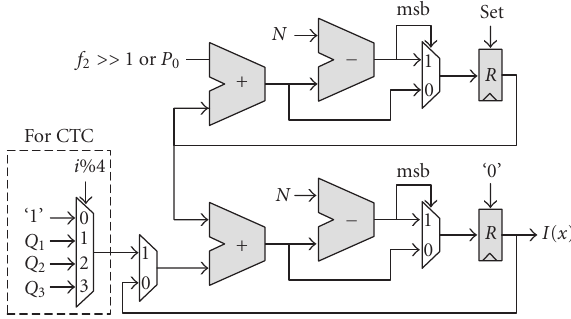
Figure 13: Simplified HW for 3GPP-LTE and CTC